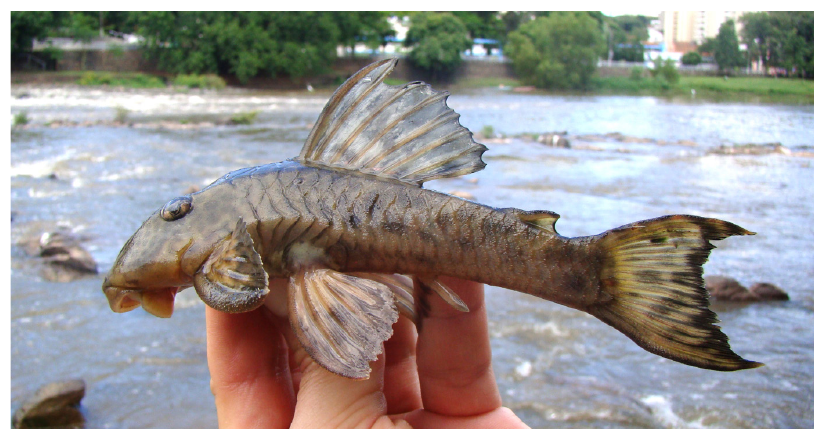
FIGURE 3 | Hypostomus hermanni , in life. NUP 16526, topotype, 134.4 mm SL; Brazil, São Paulo State, Piracicaba, Piracicaba River, Upper Paraná River basin.